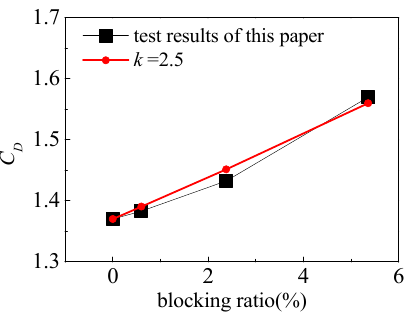
Figure 8. The drag coefficient varying with the blockage ratio.